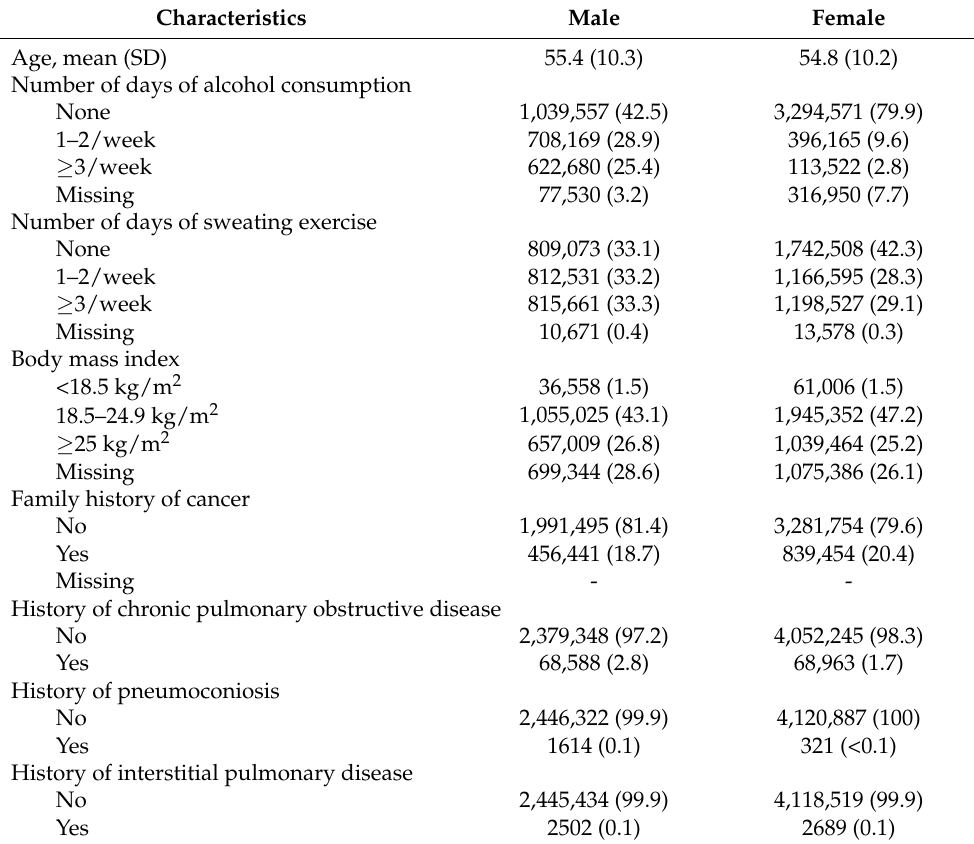
Table 1. Baseline characteristics of the study